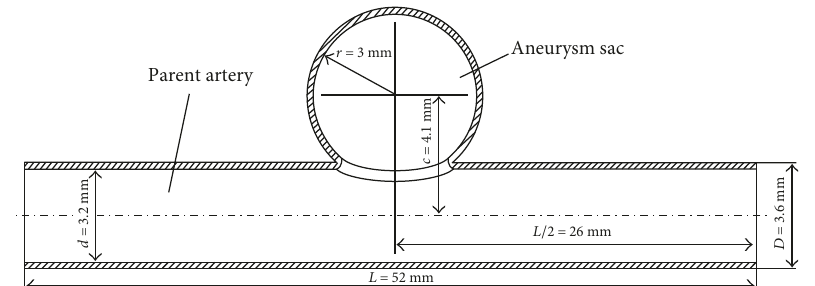
Figure 1: 3D model of ideal intracranial